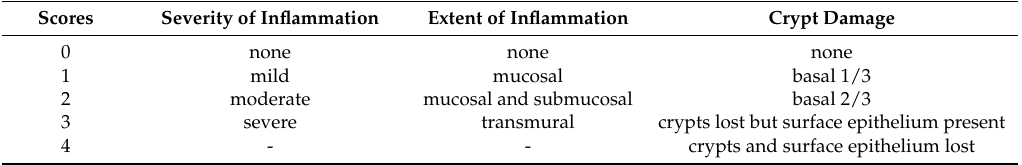
Table 2. Histological